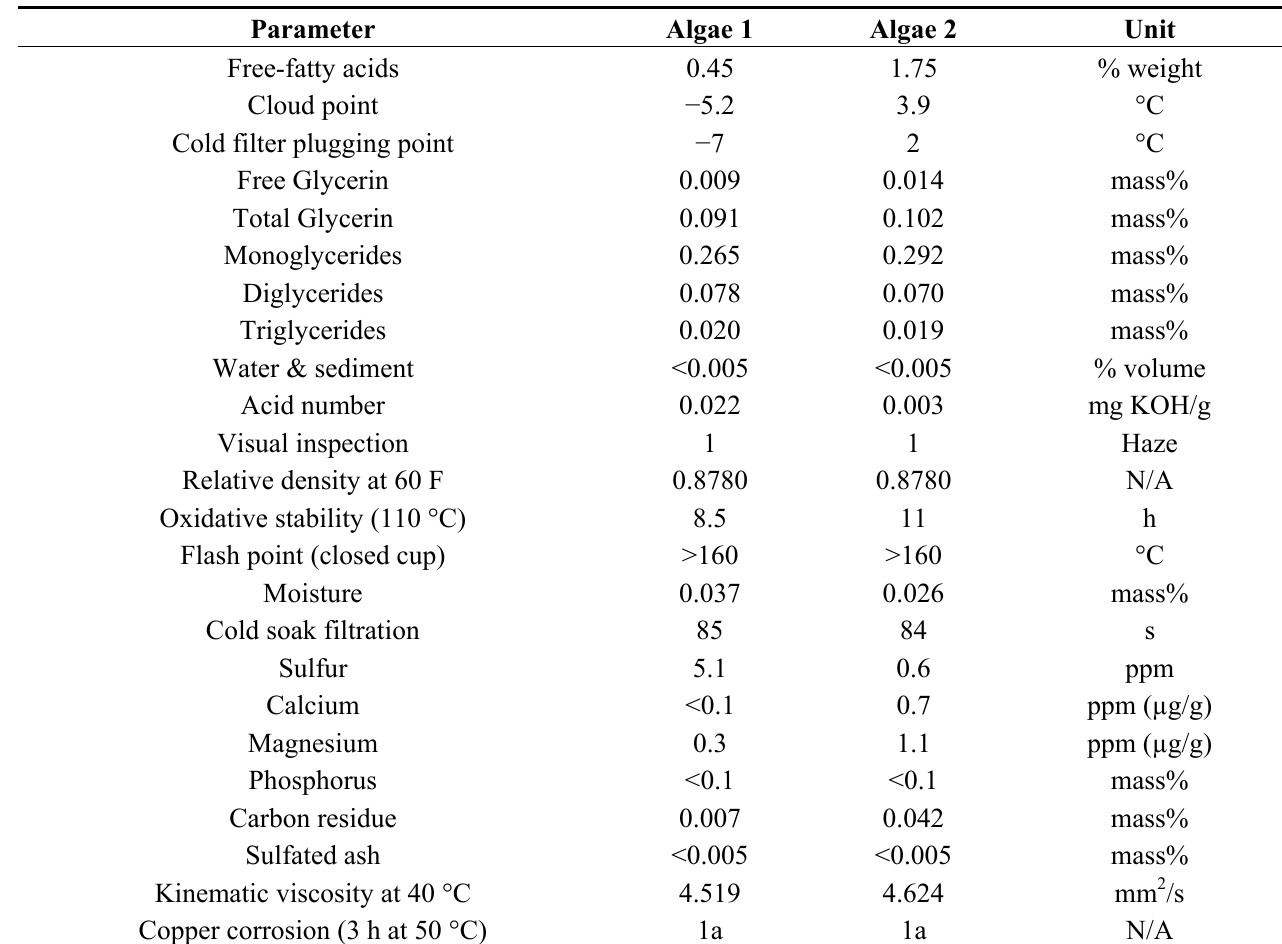
Table 2. Algae biodiesel properties